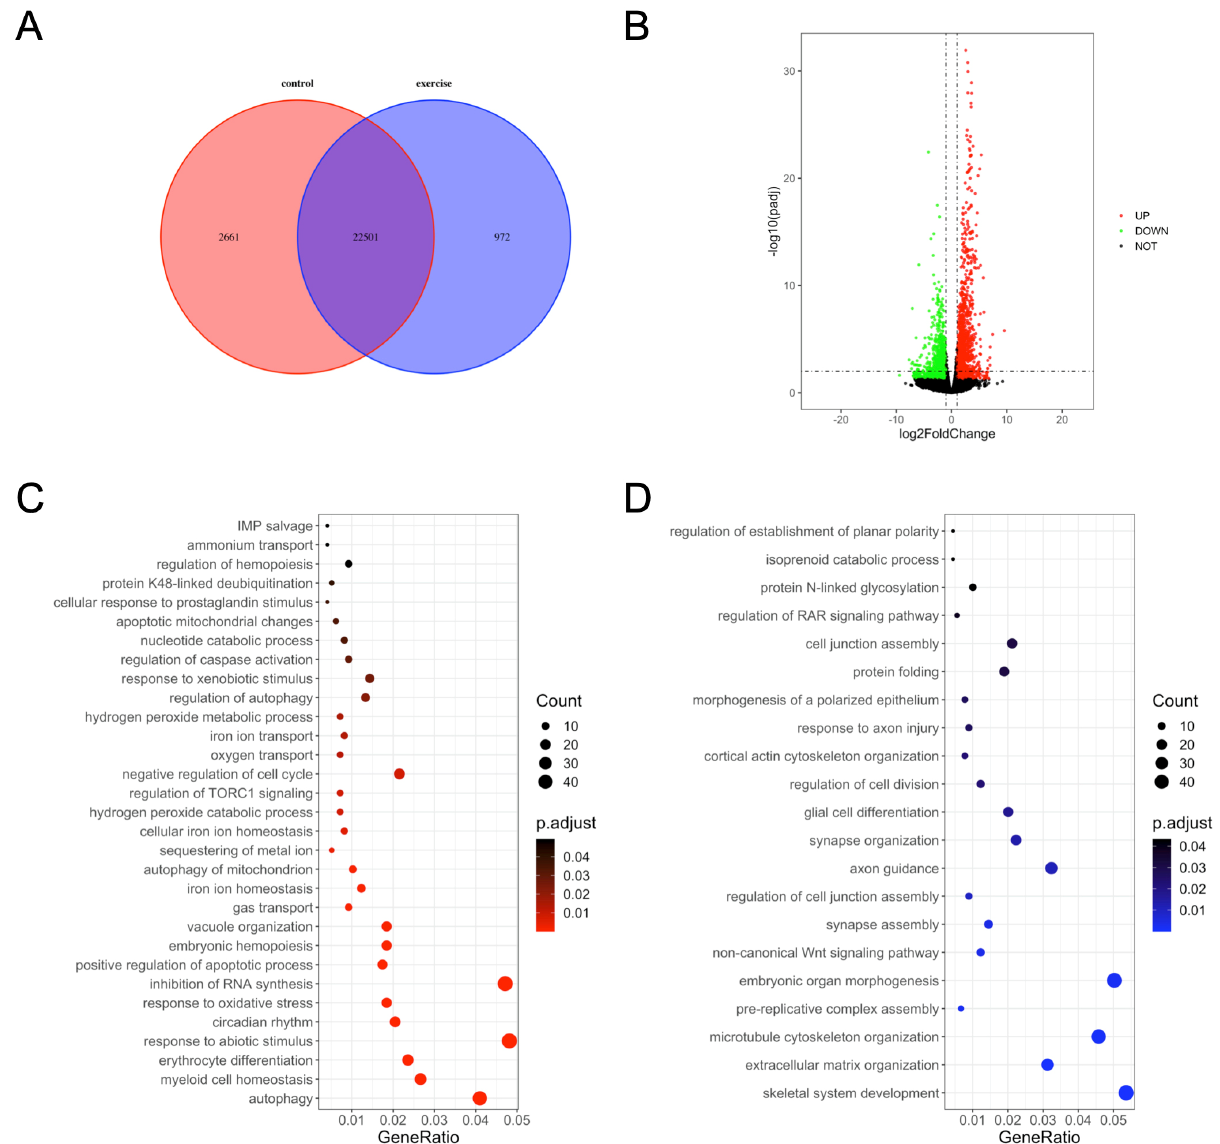
Figure 2. Gene ontology (GO) enrichment analysis of differentially expressed genes in zebrafish skeletal muscles. ( A ) Venn diagram of the total number of identified genes. ( B ) Volcano plot constructed using fold change values and Padj value. Red: upregulated, green: downregulated, gray: nonsignificant. ( C ) GO terms enriched in upregulated genes. ( D ) GO terms enriched in downregulated genes.